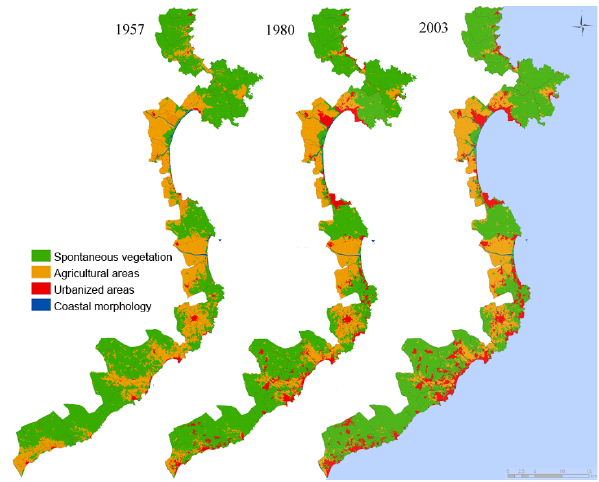
Fig. 2. Main land use changes in the Costa Brava between 1957 and 2003 (source: Mart´ı,